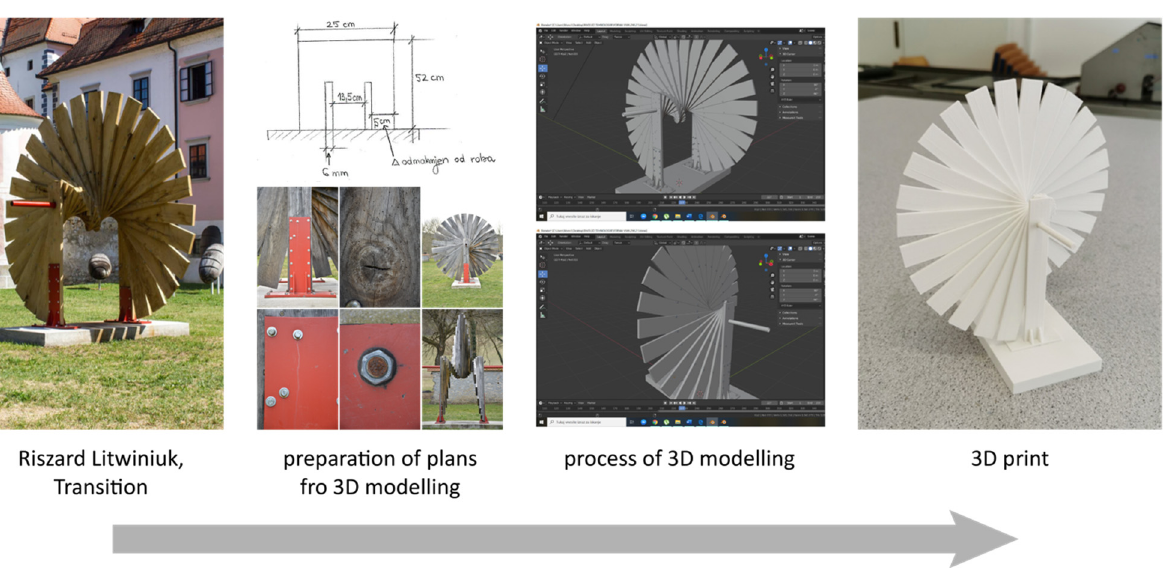
Figure 7. Three-dimensional presentations of sculptures in 3D viewer Sketchfab.